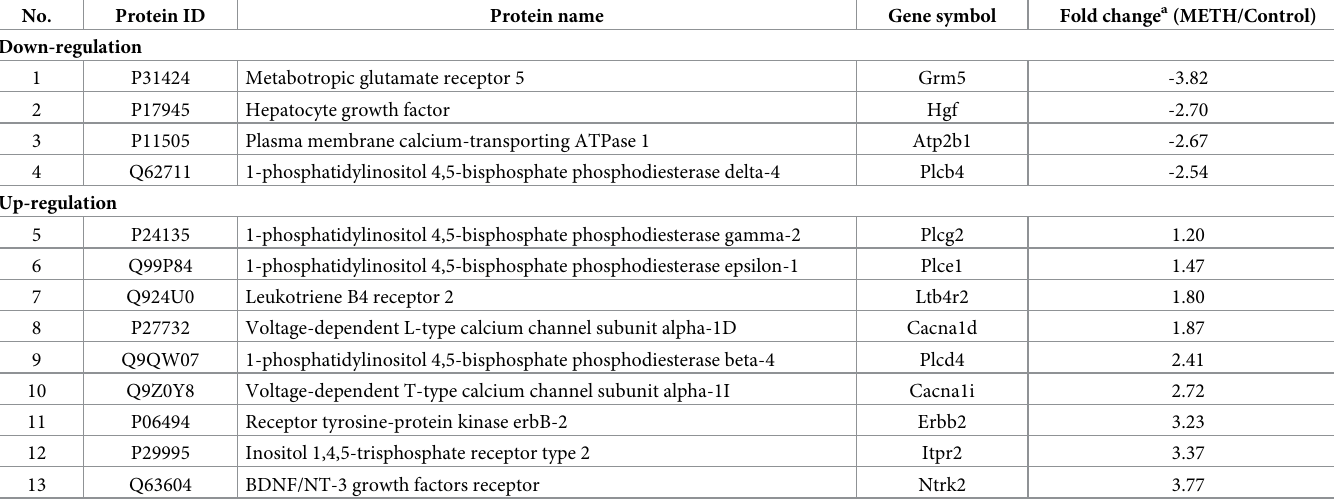
Table 2. Differentially expressed proteins of the calcium signalling pathway in rat testis (METH vs. control).